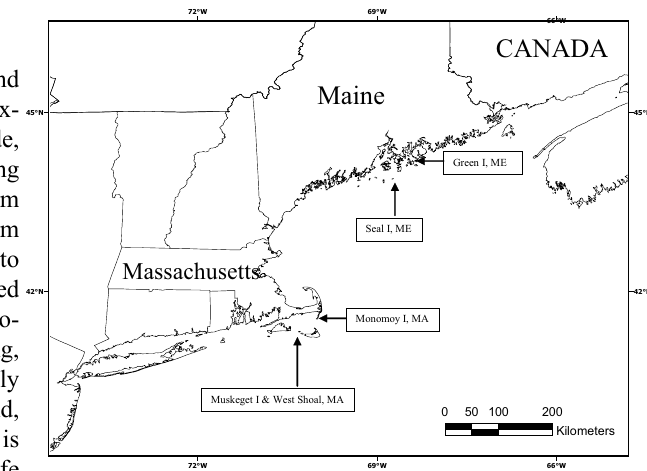
Fig. 1 . Locations of 2002 grey seal survey sites in the U.S.